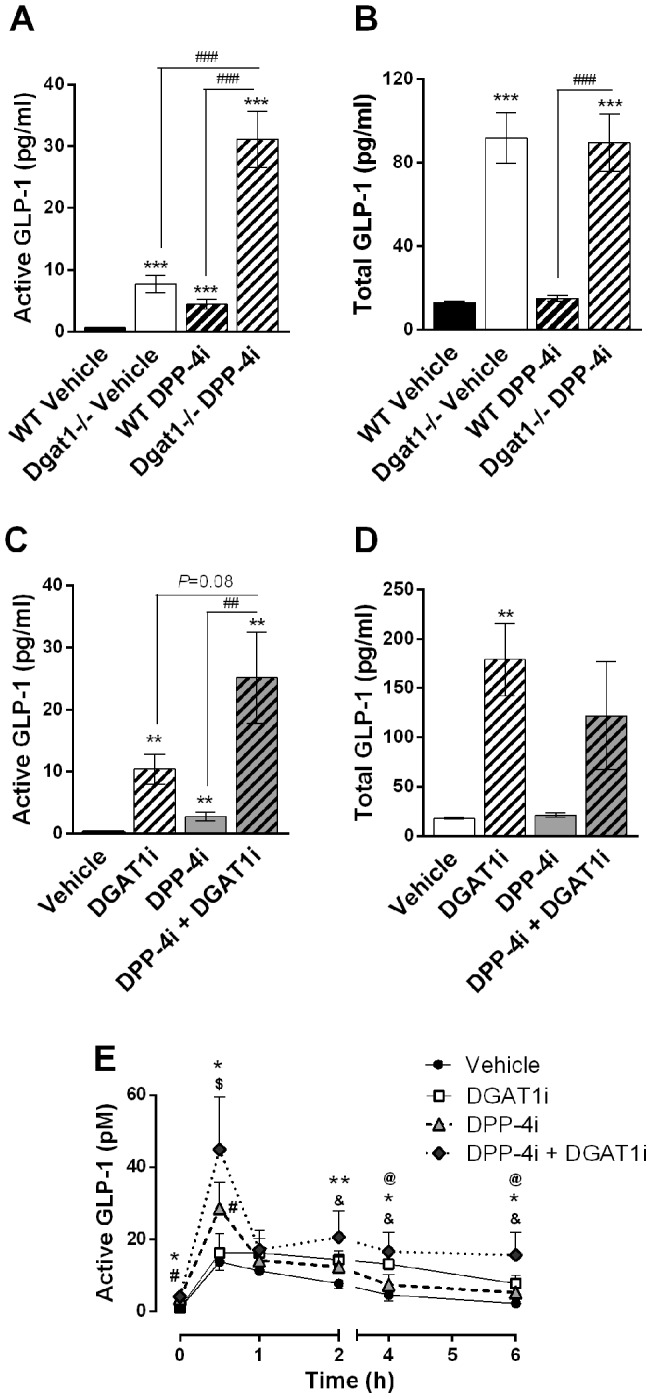
Combined effects of DGAT1 with DPP-4 inhibition on GLP-1.(A, B) 3-month-old lean Dgat1−/− and wild type mice were fasted overnight, then p.o. dosed with vehicle or a DPP-4 inhibitor (10 mg/kg) at -1 h. At time 0, mice were p.o. dosed with a meal containing 28.9% lipid load. (A) Plasma active GLP-1 and (B) total GLP-1 were measured at 2 h after meal challenge. N = 8. **P<0.01, ***P<0.001 vs. vehicle. ###P<0.001 between indicated groups. (C, D) 5-month-old DIO mice were p.o. dosed vehicle or DGATi (1 mg/kg) at -18 h and fasted overnight, then received vehicle or DPP-4 inhibitor (10 mg/kg) treatment at -1 h. At time 0, mice were p.o. dosed a meal with 28.9% lipid load, and plasma (C) active GLP-1 and (D) total GLP-1 were measured at 2h after meal challenge. N = 8. **P<0.01, ***P<0.001 vs. vehicle. ##P<0.01 between indicated groups. (E) Lean male beagle dogs were fasted overnight, then p.o. dosed the next morning (time -2 h) with vehicle, DGAT1i (0.3 mg/kg), DPP-4i (3 mg/kg), or a combination of DGAT1i and DPP-4i. At time 0, animals were p.o. dosed heavy cream (4 ml/kg). Serial blood samples were collected at indicated time points, and plasma active GLP-1 was measured. N = 4 for vehicle treatment, N = 6 for all other groups. *P<0.05, **P<0.01 DGAT1i/DPP-4i combo vs. vehicle. #P<0.05 DPP-4i vs. vehicle. &P<0.05 DGAT1i vs. vehicle. $P<0.05 combo vs. DGAT1i alone. @P<0.05 combo vs. DPP-4i alone.